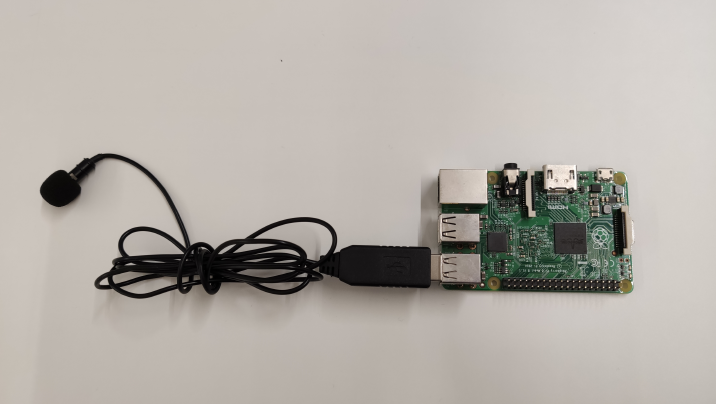
Figure 2. Raspberry Pi Model 2B with USB